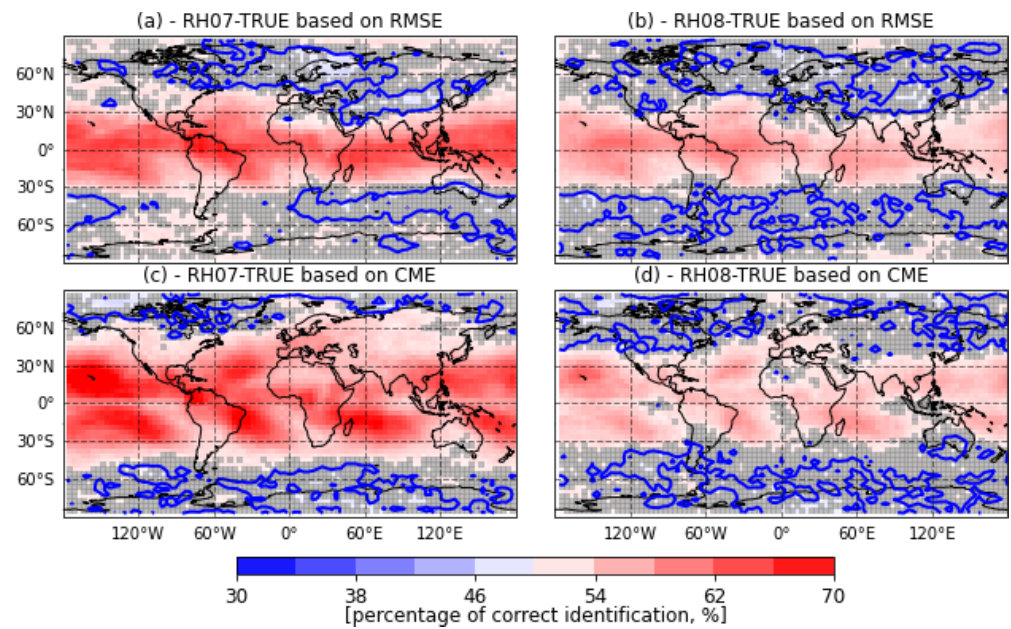
Figure 8. Percentage of correct identification between the RH07 and TRUE catalog (a, c) and between the RH08 and TRUE catalogs (b, d) using AnDA. The percentage of correct identification is computed using either RMSE f or CME ( a and b , c and d respectively). The gray shade indicate values which are below the 95% statistical significance level. The blue line corresponds to a 50% of correct